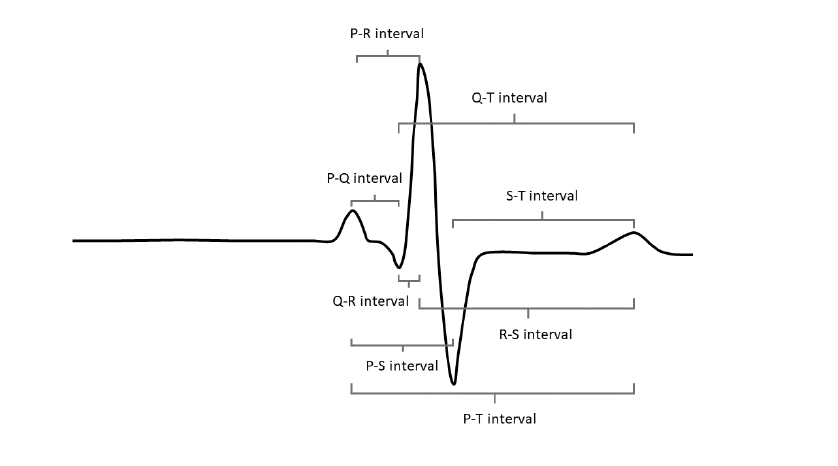
Figure 1. All waveform features of a classic ECG signal. This includes small peak intervals entered as candidate features into the novel feature model